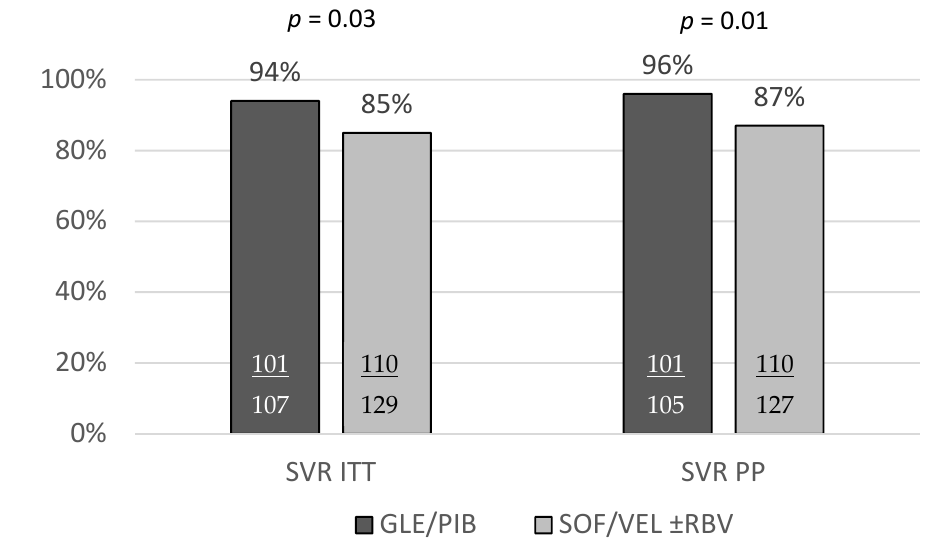
Figure 1. The comparison of the SVR rates between GT3 HCV infected patients with liver cirrhosis treated with GLE/PIB and SOF/VEL ± RBV